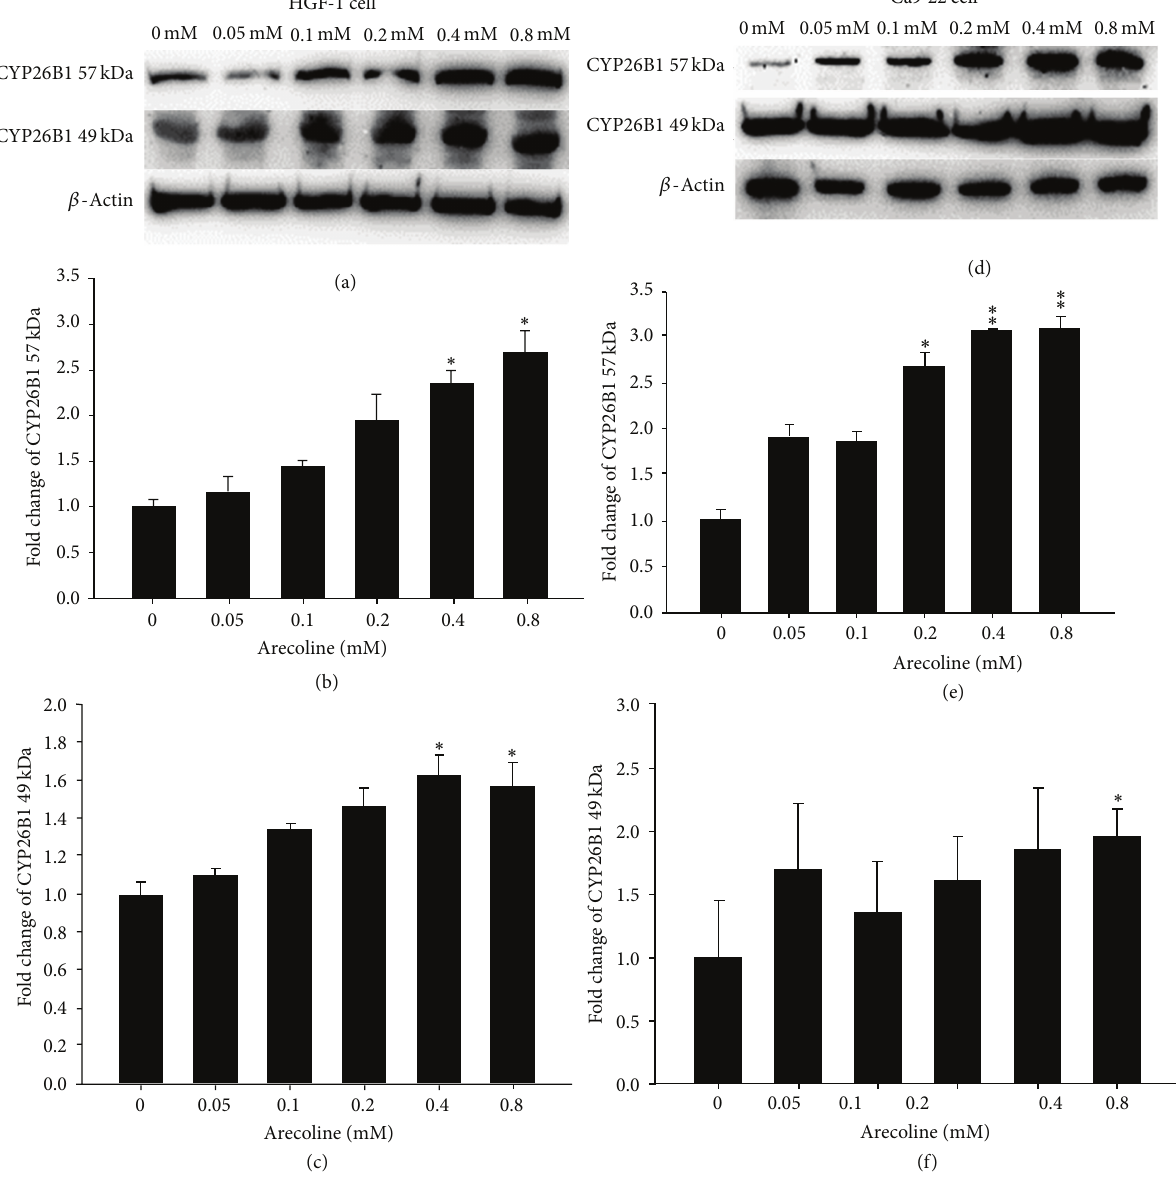
Figure 3: Expression of CYP26B1 induced by arecoline for 24 h in cultured HGF-1 and Ca9-22 cells. (a) Expression of full-length CYP26B1 (57 kDa) and the splice variant (49 kDa) in HGF-1 cells exposed to arecoline at various concentrations compared with the control, which did not receive arecoline treatment; (b) densitometric analysis of the expression of full-length CYP26B1 bands in HGF cells; (c) densitometric analysis of the expression of the CYP26B1 splice variant in HGF-1 cells; (d) expression of full-length CYP26B1 (57 kDa) and the splice variant (49kDa)inCa9-22cellsexposedtoarecolineatvariousconcentrationscomparedwiththecontrol;(e)densitometricanalysisoftheexpression offull-lengthCYP26B1bandsinCa9-22cells;(f)densitometricanalysisoftheexpressionoftheCYP26B1splicevariantinCa9-22cells.Mean ± SD; ∗ 𝑃 < 0.05 ; ∗∗ 𝑃 < 0.01 ; 𝑛 = 3